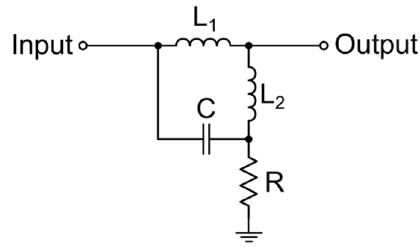
Figure 7. Lumped-component bridged-tee network.